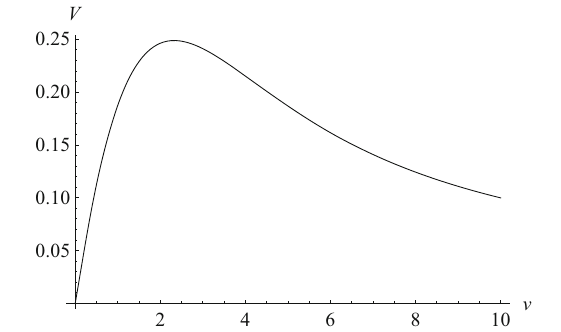
Fig. 1 Graph of V ( v ) for the sixth-order gravity with degenerate